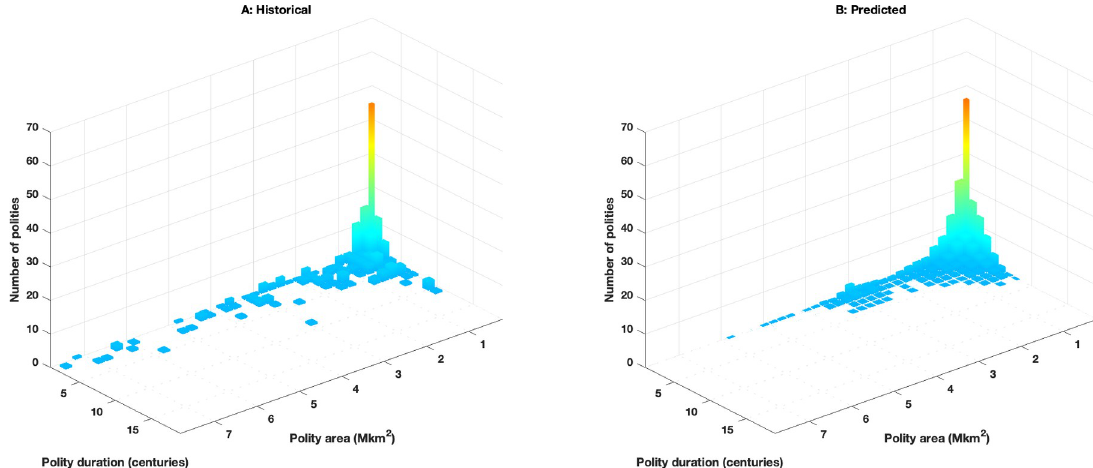
Fig 5. Polity size and duration distribution. Historical ( A ) and mean predicted ( B ) distributions of peak (agrarian and nomadic) duration (in centuries) and peak size (in millions (M) of km 2 ) between 1500 BCE and 1500 CE.